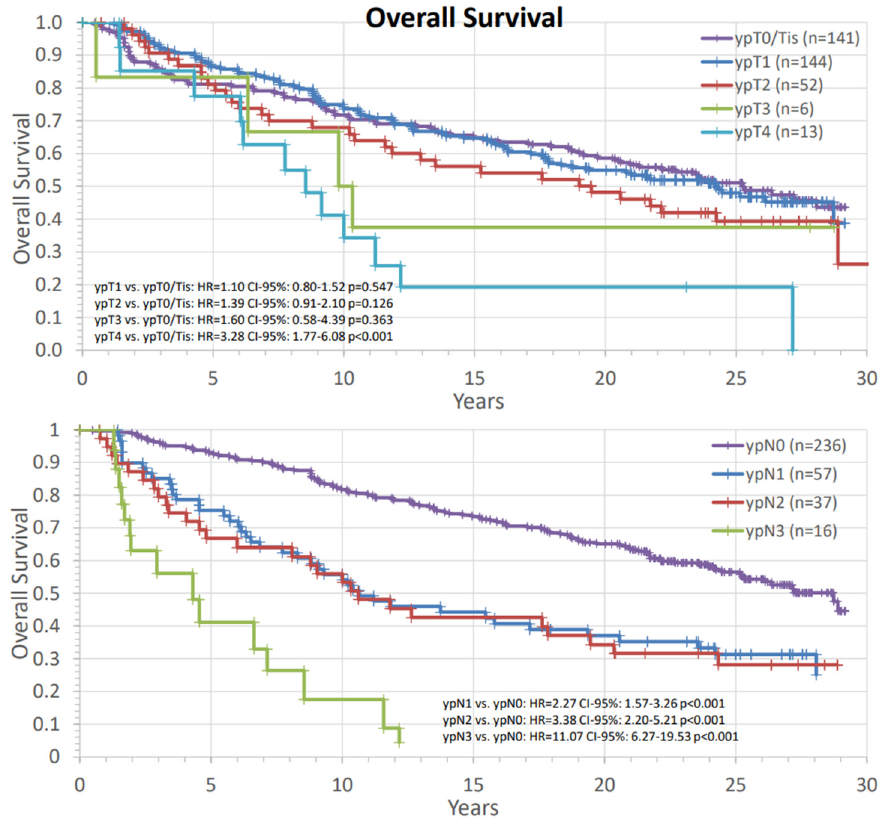
Figure 5. Analysis of survival of different postoperative T-stages and N-stages. The comparisons are presented with hazard ratios and their corresponding confidence intervals and p -values against ypT0/Tis and ypN0. HR: hazard ratio, ypT: postoperative primary tumor stage, ypN: postoperative nodal stage, CI: confidence interval, n: number of patients.